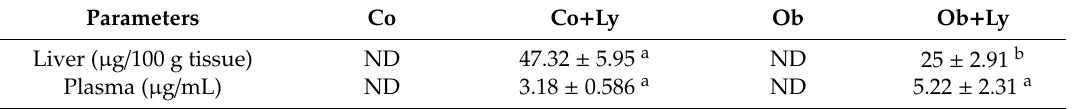
Table 2. Lycopene concentration in hepatic tissue and plasma.